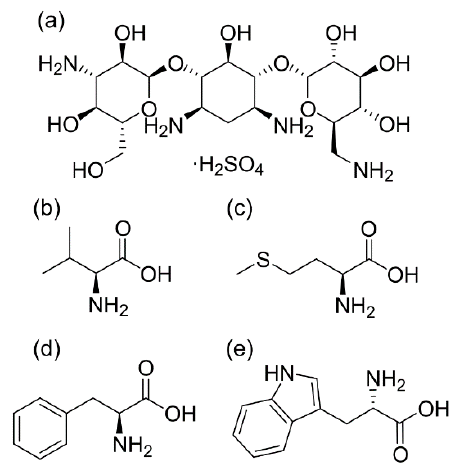
Figure 1. Chemical structures of ( a ) kanamycin sulfate, ( b ) L-valine, ( c ) L-methionine, ( d ) L-phenylalanine, and ( e ) L-tryptophan .